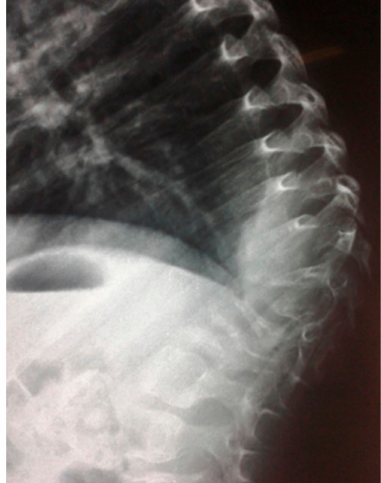
Figure 1. Lateral spine radiograph of a 7-year old boy showed kyphosis resulted from osteolysis of T9-L1 (fish-like vertebrae). The left iliac crest was also involved in the pathological process of osteolysis. 2. A ten-year-old-girl presented with painful acute upper thoracic kyphosis. Radiographs of the spine were di ffi cult to assess. 3D reformatted CT scan of the thoracic spine showed progressive osteolysis of T3-T6 (Figure 2). Skeletal survey did not show any other involved areas.